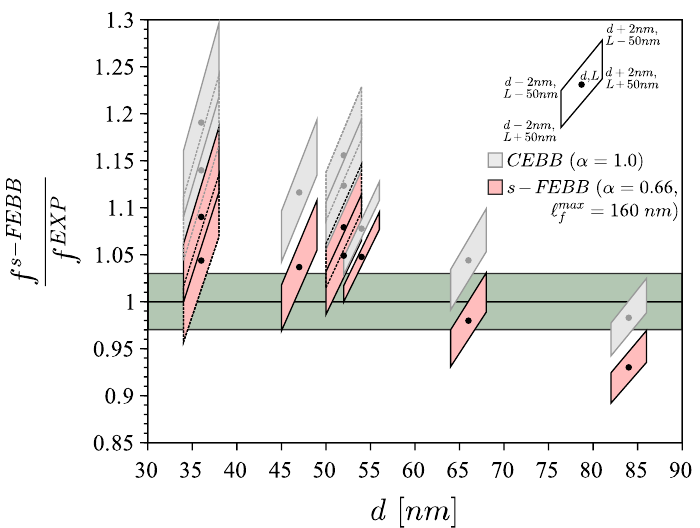
Figure 13. The comparison of experimental measurements [38] (resonance frequencies f EXP , see also Table 6) of GaN nanobeams vs. classical model (CEBB) and s-FEBB model (see also Equations (16 1 ) and (18 1